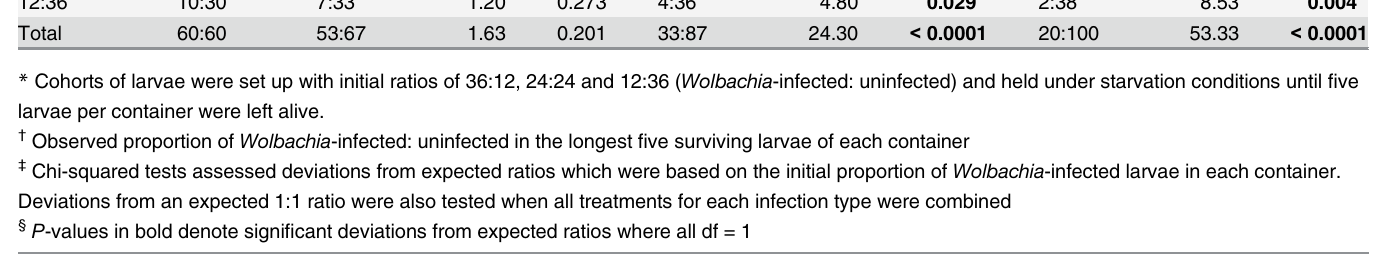
Table 2. Wolbachia infection frequencies in surviving Ae . aegypti larvae when held at different initial proportions under starvation conditions. Observed proportion Wolbachia -infected: